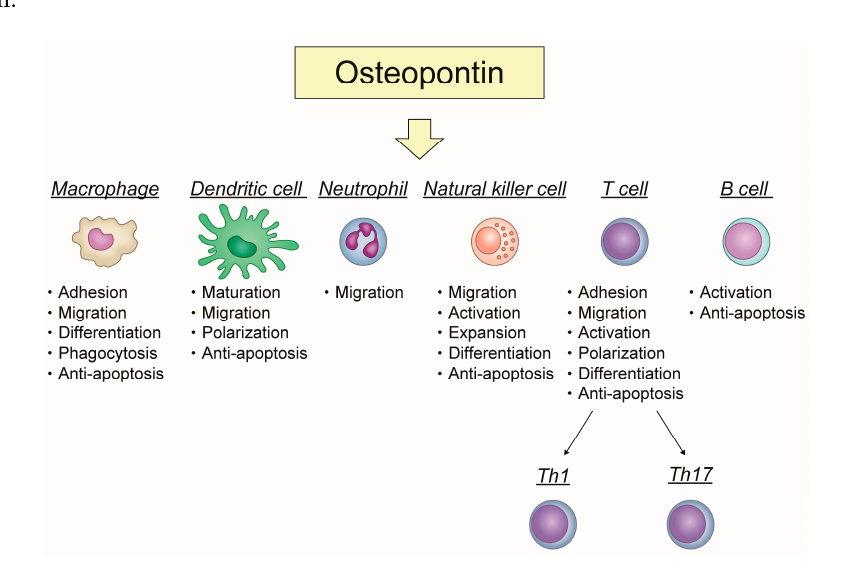
Figure 1. The role of osteopontin in immune cells focusing on the relationship between inflammation and